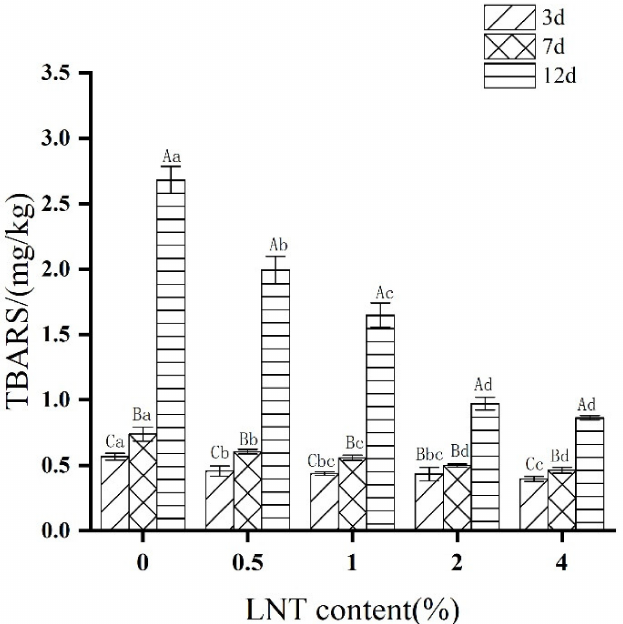
Figure 1. Effects of LNT content and storage time on TBARS of goose meatballs during cold stor- age (4 ◦ C). Capital letters indicate significant differences between different storage times for the same sample ( p ≤ 0.05). Lowercase letters indicate significant differences between different contents of LNT sample during the same storage time ( p ≤